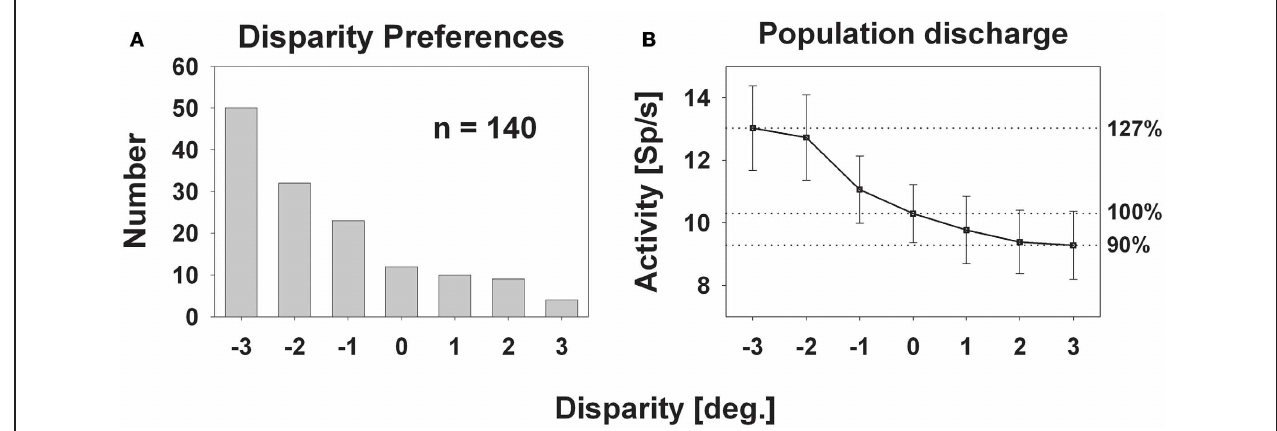
FIGURE 4 | Disparity tuning: population level. The histogram in panel (A) shows the number of cases for which the peak discharge of a single cell was found at a certain disparity. The largest number (50) was found for the stimulus closest to the monkey: − 3 ◦ disparity corresponding to 27cm in front of the monkey. The smallest number